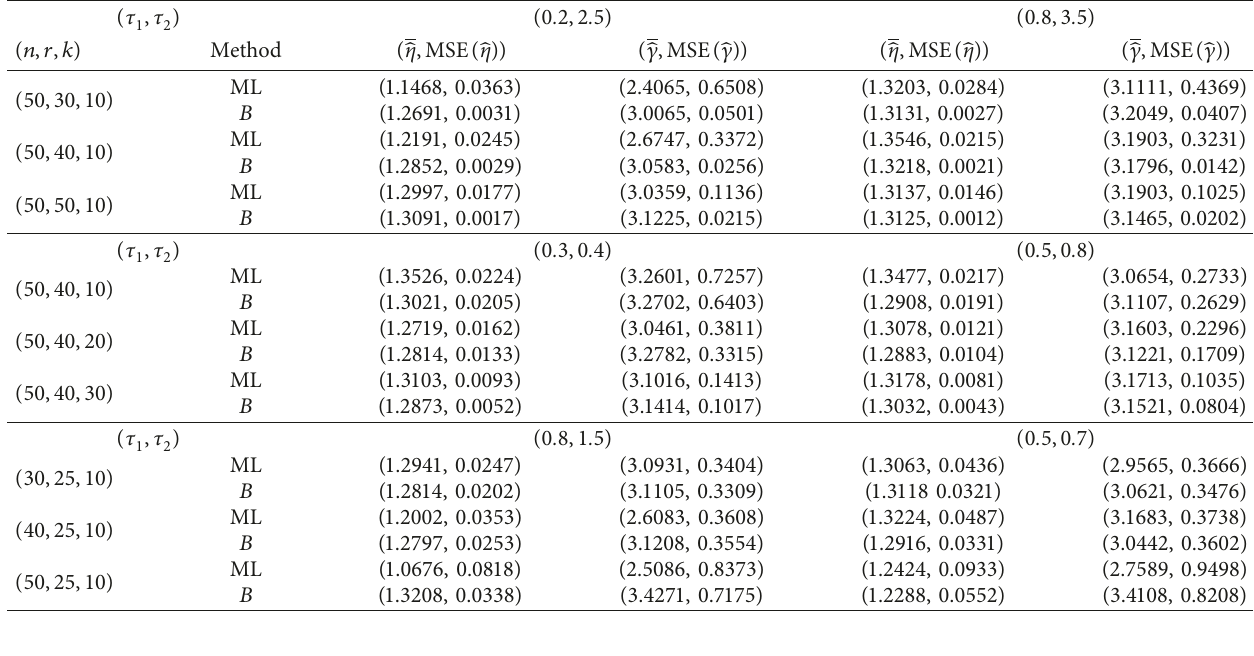
� 3 . 0 ,c � 1 . 8 ,c � 0 . 6 ) based on 1 2 3